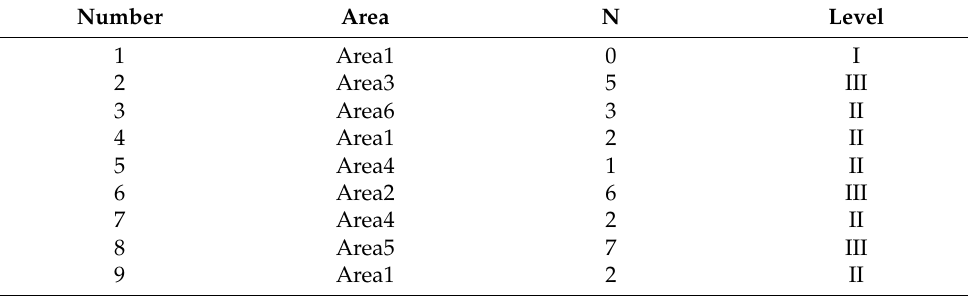
Table 3. Local anode effect